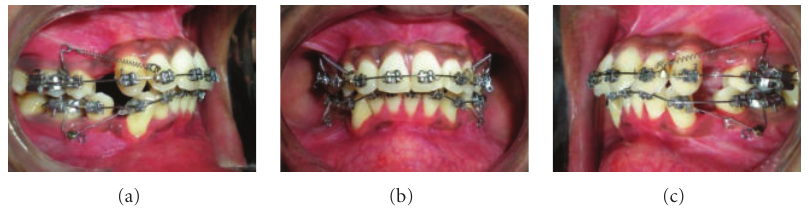
Figure 9: (a, b, c) MSPAs were inserted in the auxiliary molar tube and slot of the miniscrew head at all four quadrants. Mandibular MSPAs were without vertical-hooked-arm. Due to less initial crowding and increased overjet, maxillary en-masse retraction was started earlier. Mandibular canine retraction continued further keeping them in class I relation.